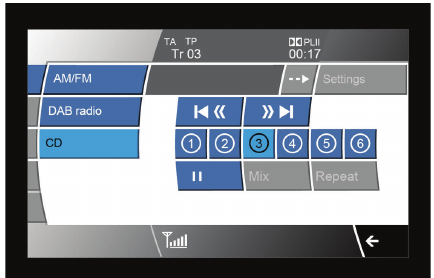
Figure 2: Touchscreen evaluation interface screenshot.